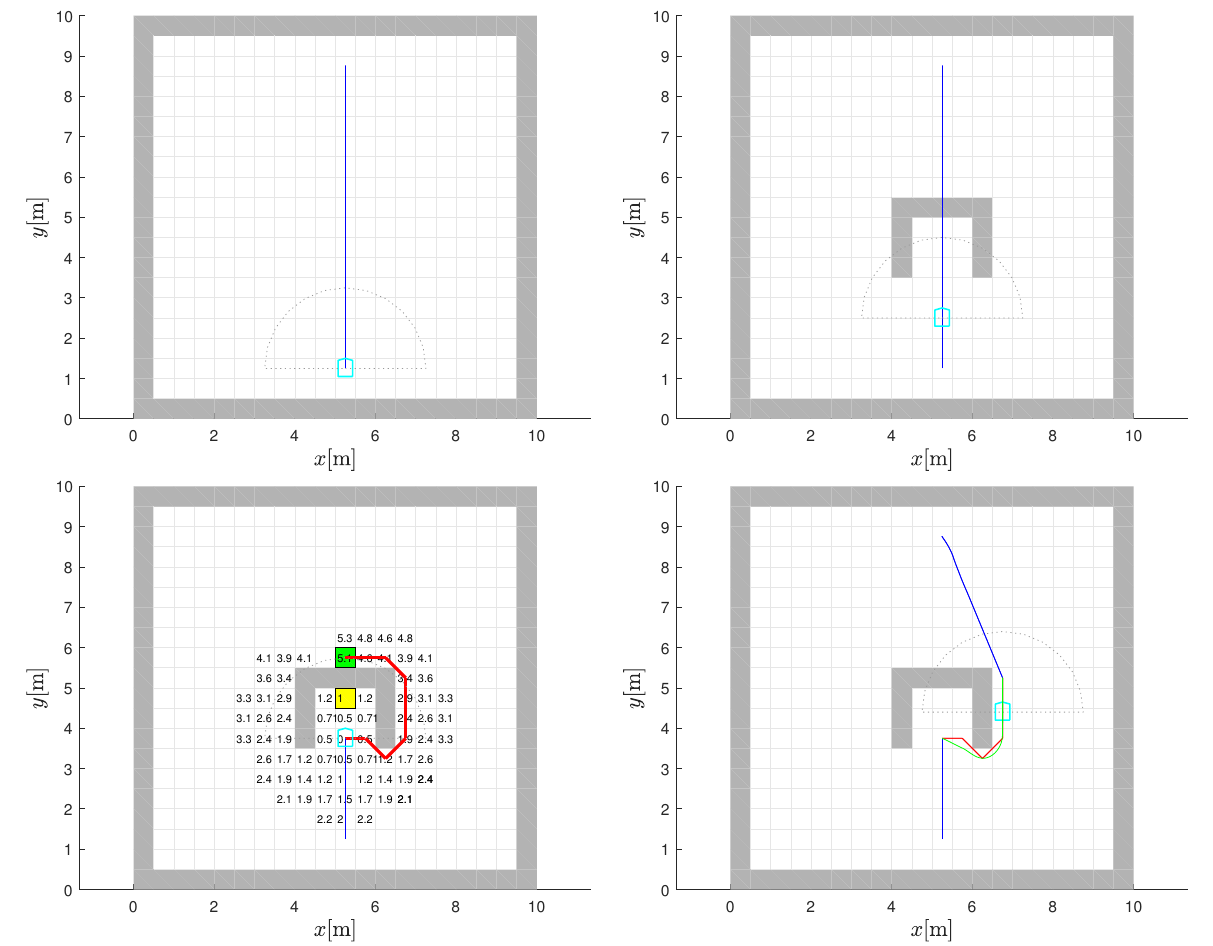
Figure 11. Path planning with appearance of unexpected U-shaped trap. Robot initially plans path (blue line) in empty static map ( top-left ) and starts to travel on it ( top-right ). When blockage is within sensor range, a bypass path is computed by a red line ( bottom-left ). The path is smoothed (green line) and connects with the final gradient-descent path (blue line) using CtG ( bottom-right ). In accordance with the algorithm, a 5 by 5 window of cells is examined around the stuck cell (the yellow cell in Figure 11 (bottom-left) where the robot’s initial gradient- descent path is blocked by the obstacle) to find the lowest CtG value below the current one (temporary intermediate goal cell marked by green in Figure 11 (bottom-left)). As explained earlier, such a cell is considered as being in an area where the CtG values are unaffected by the new blockage. If in some other case, the chosen 5 by 5 search window size does not produce a suitable target, because the cell with a minimum CtG value smaller than the current value lies within the trap zone, the search can be repeated using a larger 7 by 7 window and so on. This will eventually yield a temporary bypass goal outside the trap. The A* bypass path to this cell is also shown in Figure 11 (bottom-left) in red. The smoothed version obtained by the bilinear gradient interpolation in green, the post-bypass path segment based on the gradient descent, and the overall composite path between the start and goal points is shown in Figure 11 (bottom-right). Note that the path follows the computed bypass only until the leave point where the old CtG values and its interpolated gradient-descent path can be followed